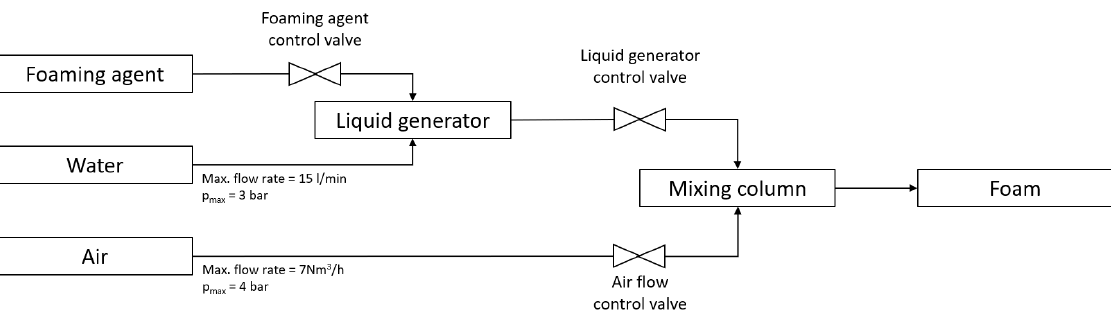
Figure 2. Foam generation scheme.